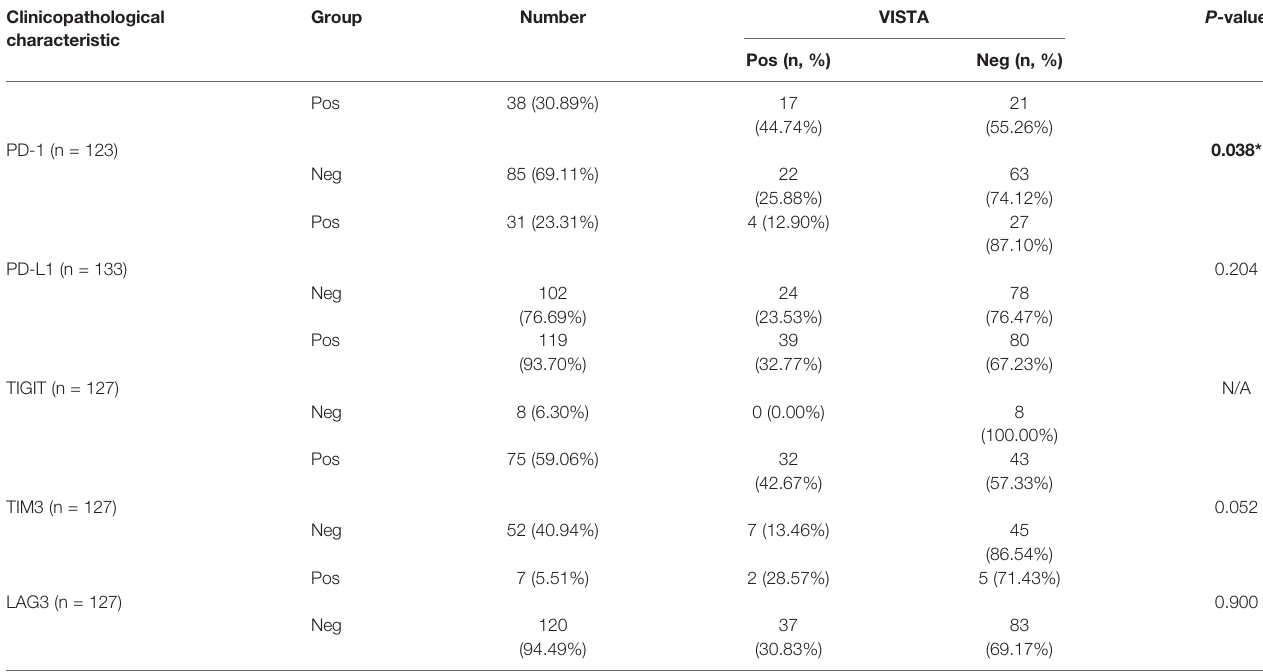
TABLE 2 | Correlation analysis between expression of VISTA protein and expression of other immune checkpoints in breast cancer patients. Clinicopathological